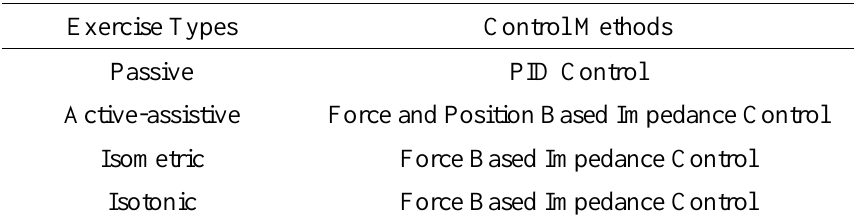
Table 5. Exercise types & control